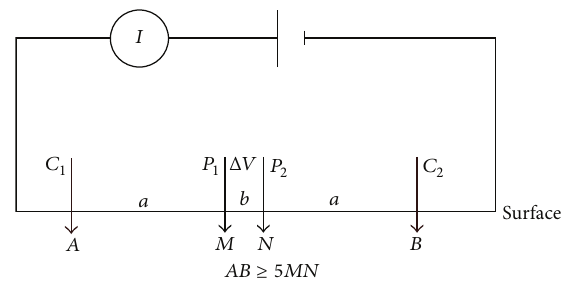
Figure 2: Electrode configuration for conventional Schlumberger array.